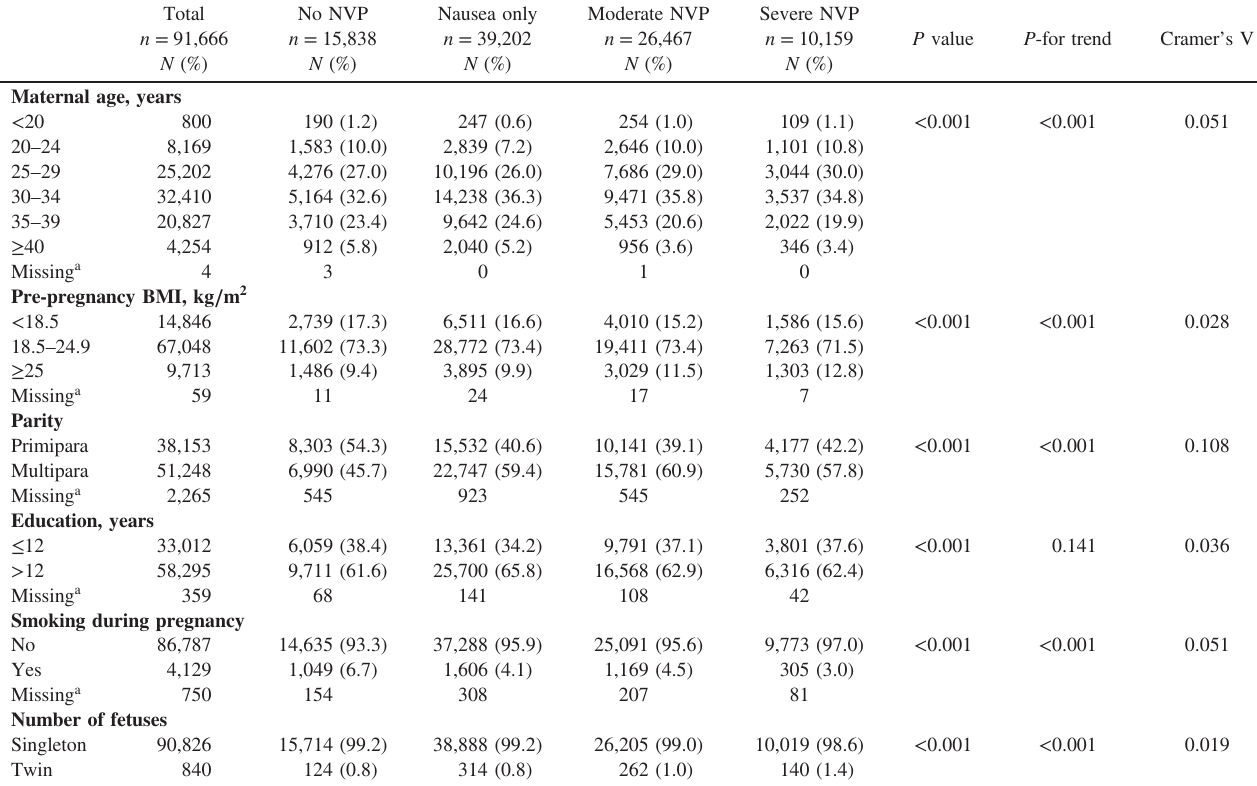
Table 1. Maternal characteristics according to NVP status